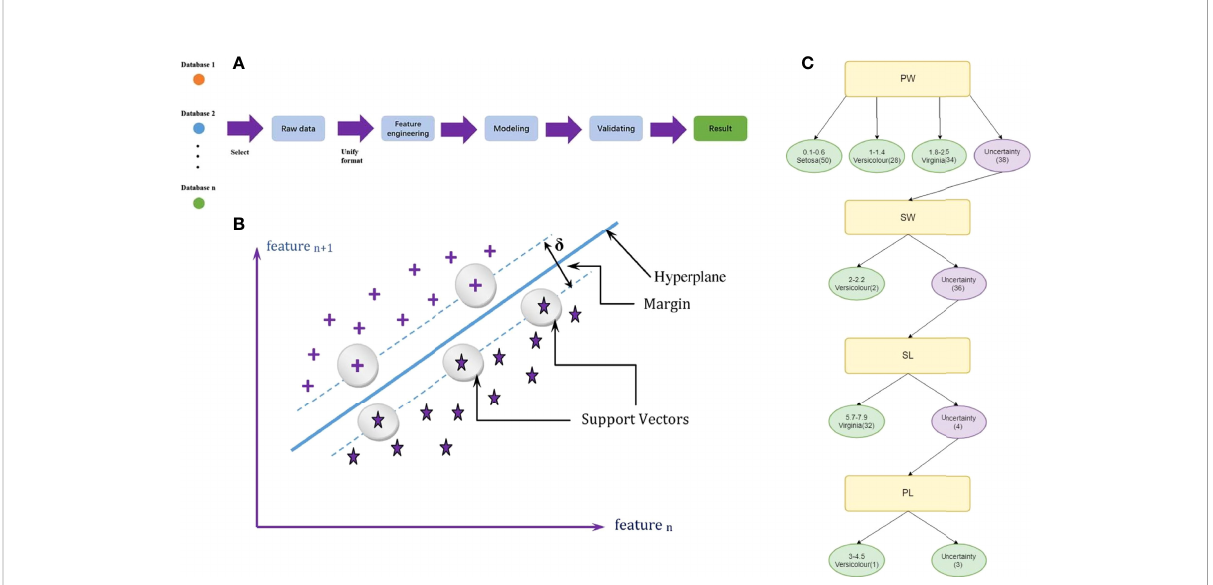
FIGURE 2 (A) Flowchart for machine learning. (reproduced from an open access article). (B) Schematic diagram of SVM. (reproduced with permission from Deka, 2014). (C) A decision tree for identi fi cation based on iris. (reproduced from an open access